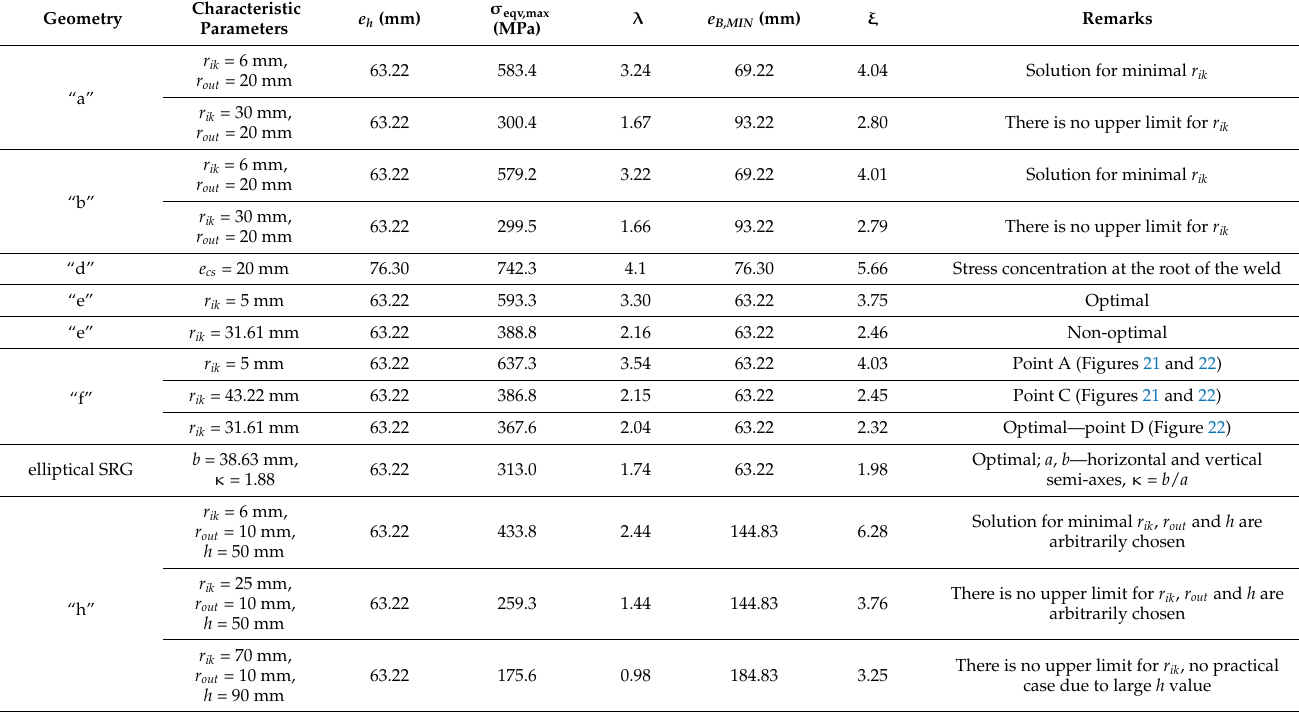
Table 3. Summary of numerical results for investigated flat ends with different geometries, pure elastic model, p c = 18.6335 MPa.